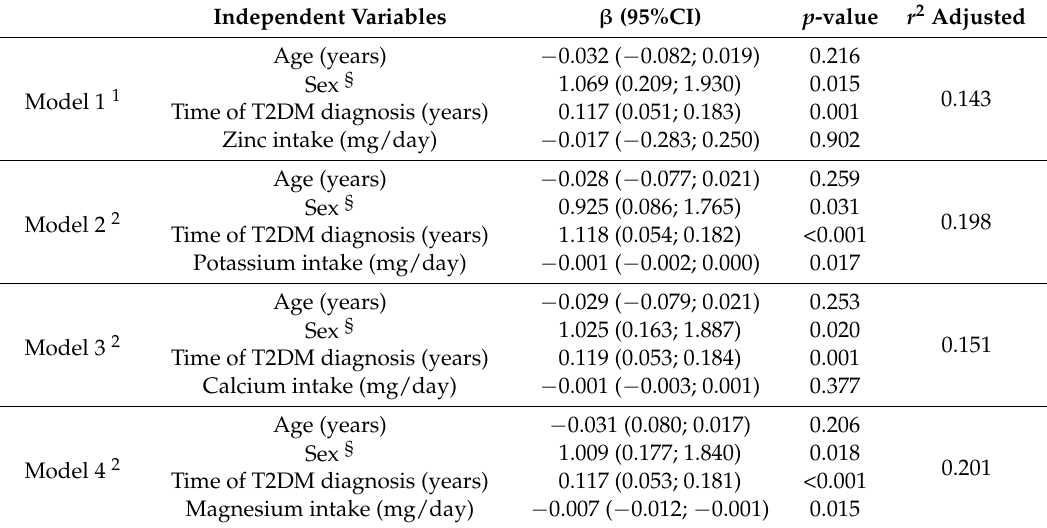
Table 4. Multiple linear regression models of glycated hemoglobin percentage (%HbA1c; dependent variable) and energy-adjusted mineral intake by individuals with type 2 diabetes mellitus